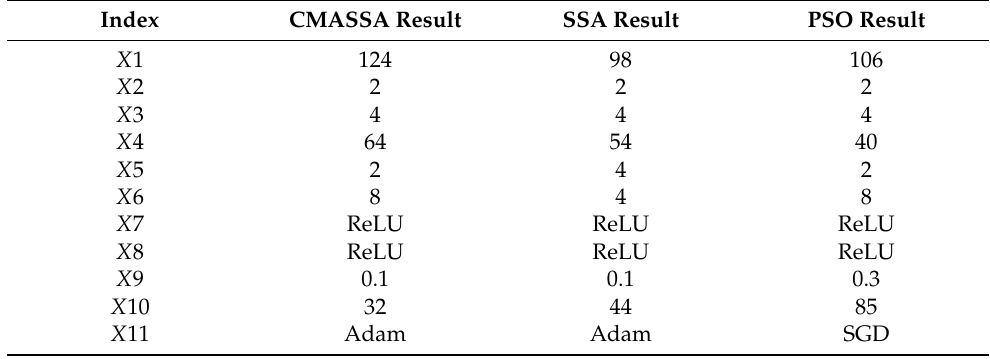
Table 7. For each optimization algorithm on MWD, the obtained CAEN optimal hyperparameters.